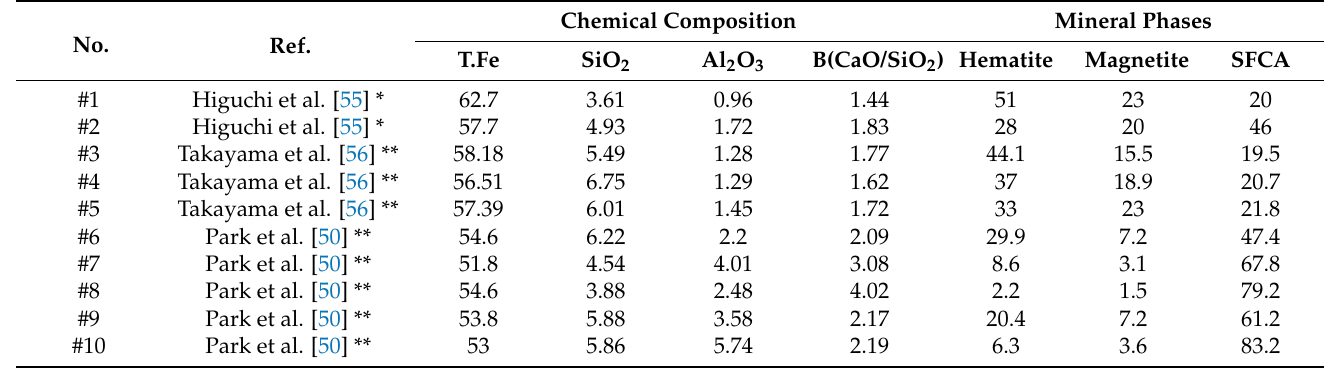
Table 5. Chemical compositions and phase fractions of iron ore sinters (wt%).